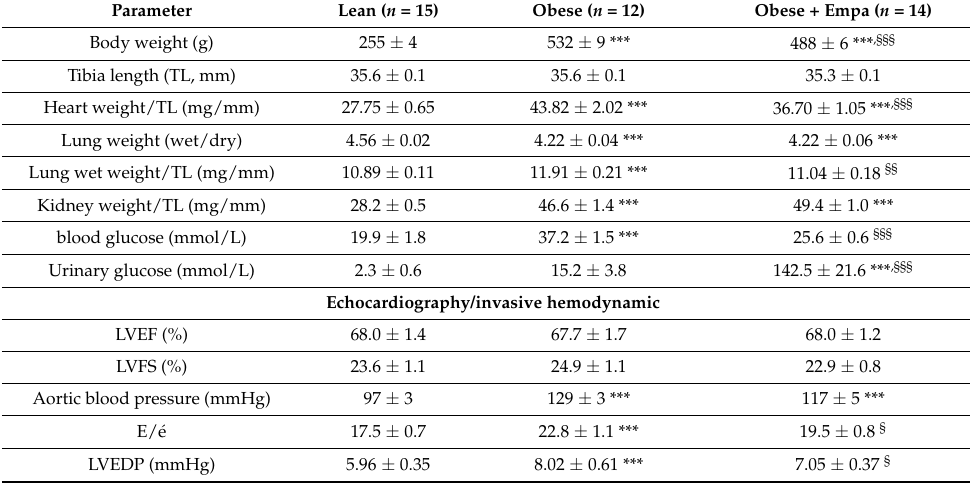
Table 1. Animal characteristics at 32 weeks of